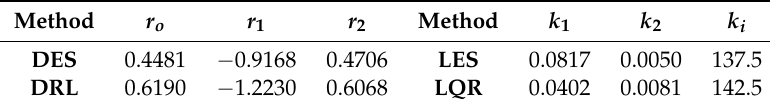
Table 2. Controllers gain designed for